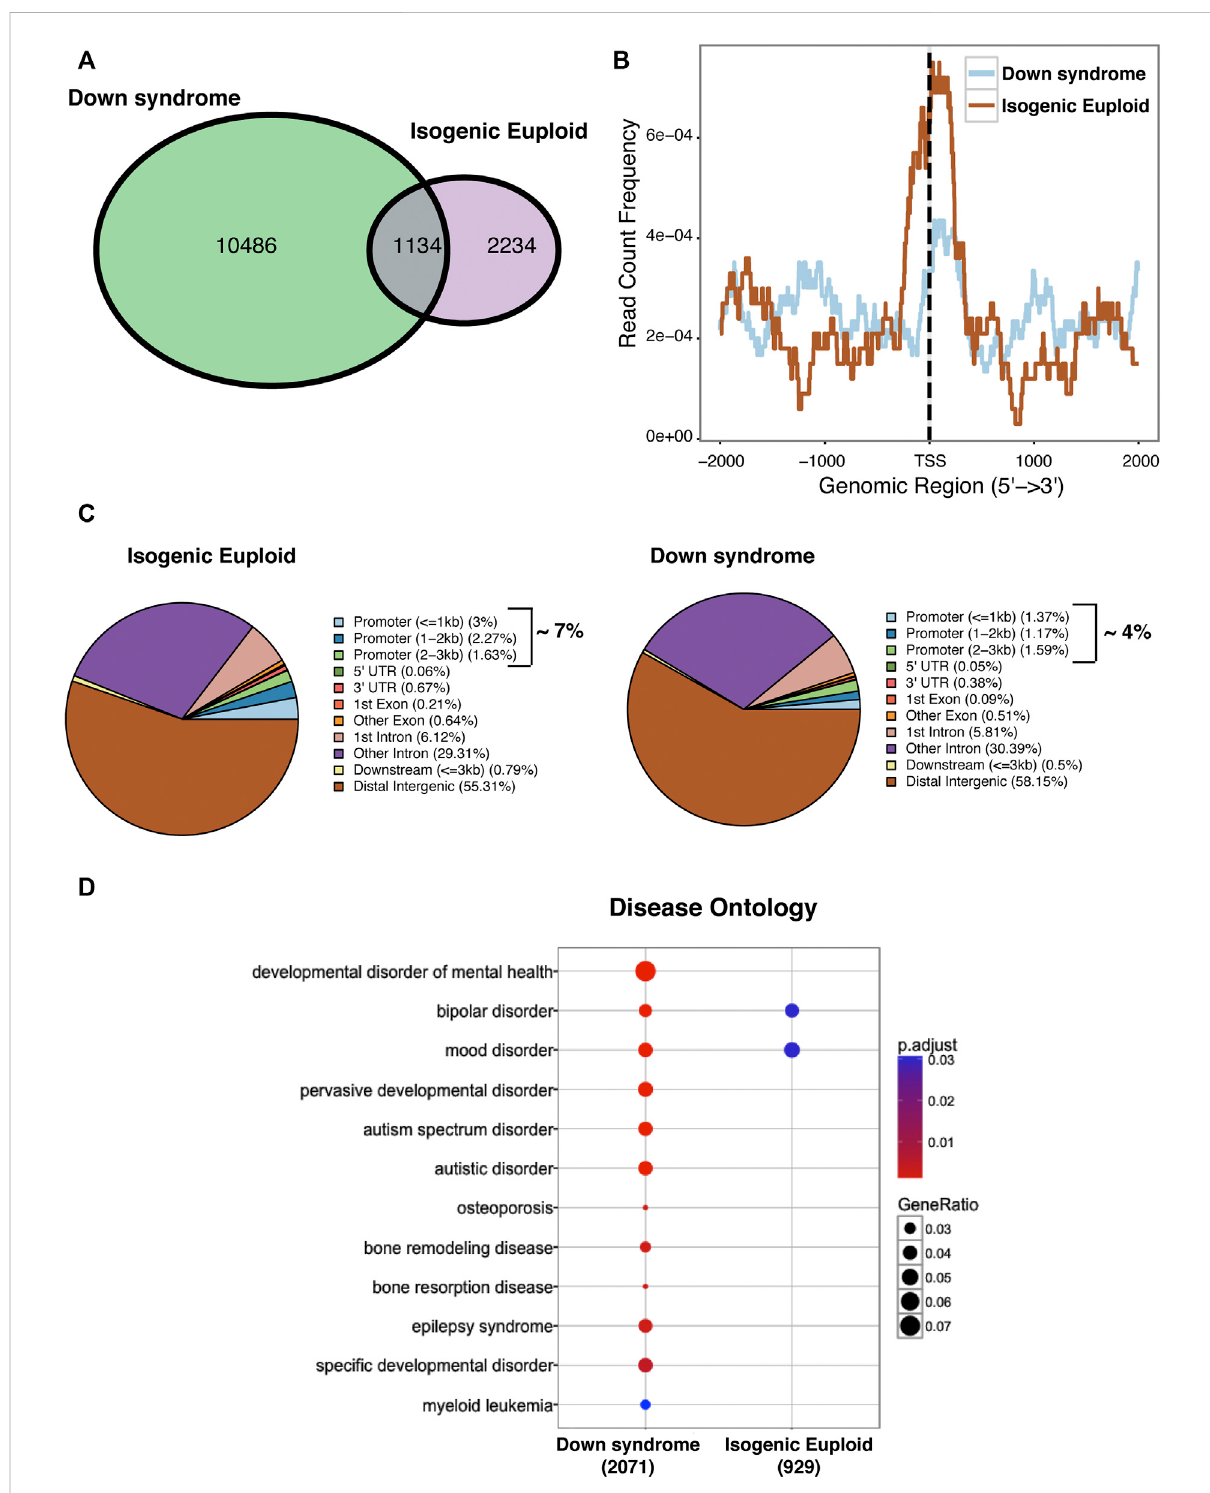
FIGURE 7 ChIPseq analysis of global PAX6 binding in DIV 24 Down syndrome and isogenic euploid cells. (A) Venn diagram showing the distribution of PAX6 binding sites in DS and isogenic euploid cells. (B) PAX6 binding pro fi le in Down syndrome and isogenic euploid cells. (C) Pie chart analysis showing PAX6 binding on various genomic regions in DSand isogenic euploid cells. (D) Disease ontology analysis using PAX6 binding sites. (Seealso Supplementary Figure